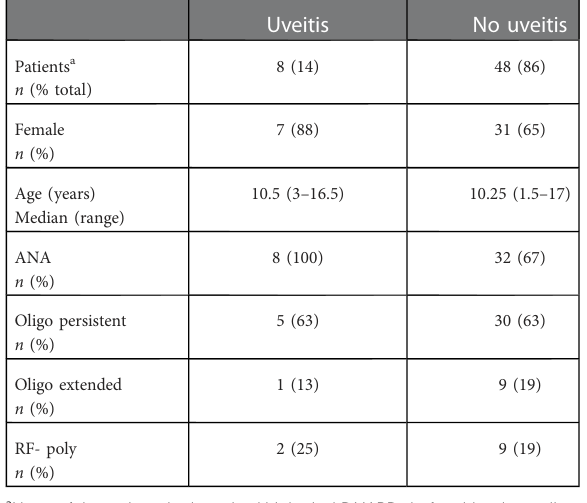
TABLE 3 Description of patient cohort included in bead array, grouped by uveitis.